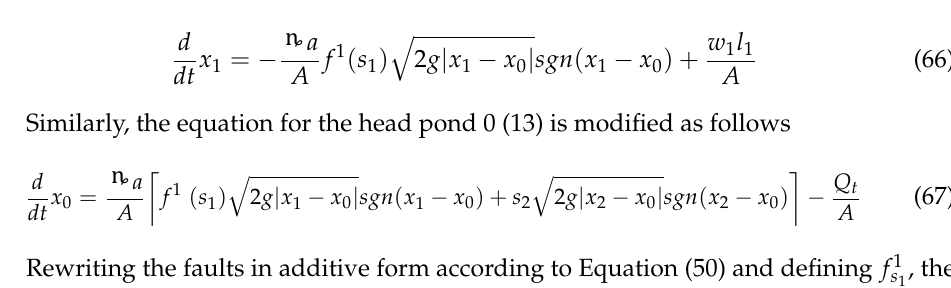
Figure 1. Three-pond hydraulic system.